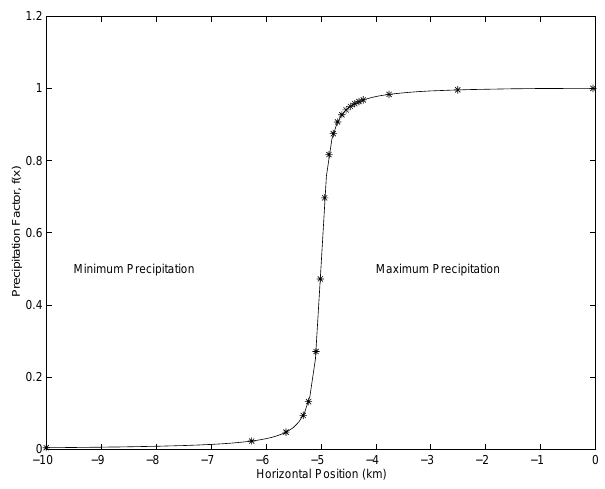
Fig. 2. Figure showing the field lines used in the